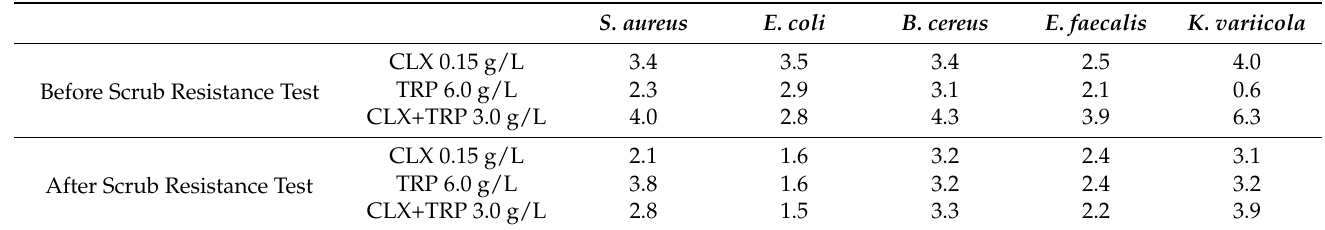
Table 1. Antibacterial activity (R) values obtained for each bacterium after contact with Chloroxylenol (CLX), Terpineol (TRP), or CLX+TRP samples, before and after scrub resistance test. S. aureus E. coli B.